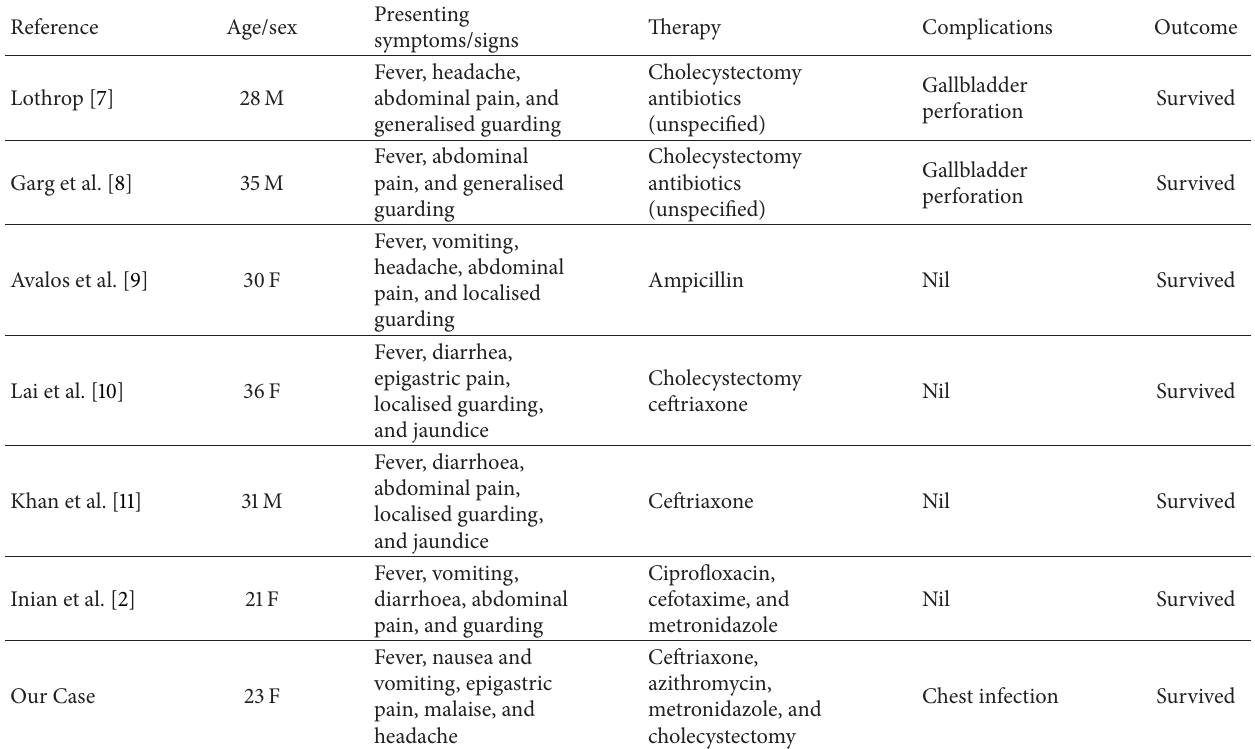
Table 2: Clinical characteristics and outcomes of reported cases of typhoidal acute acalculous